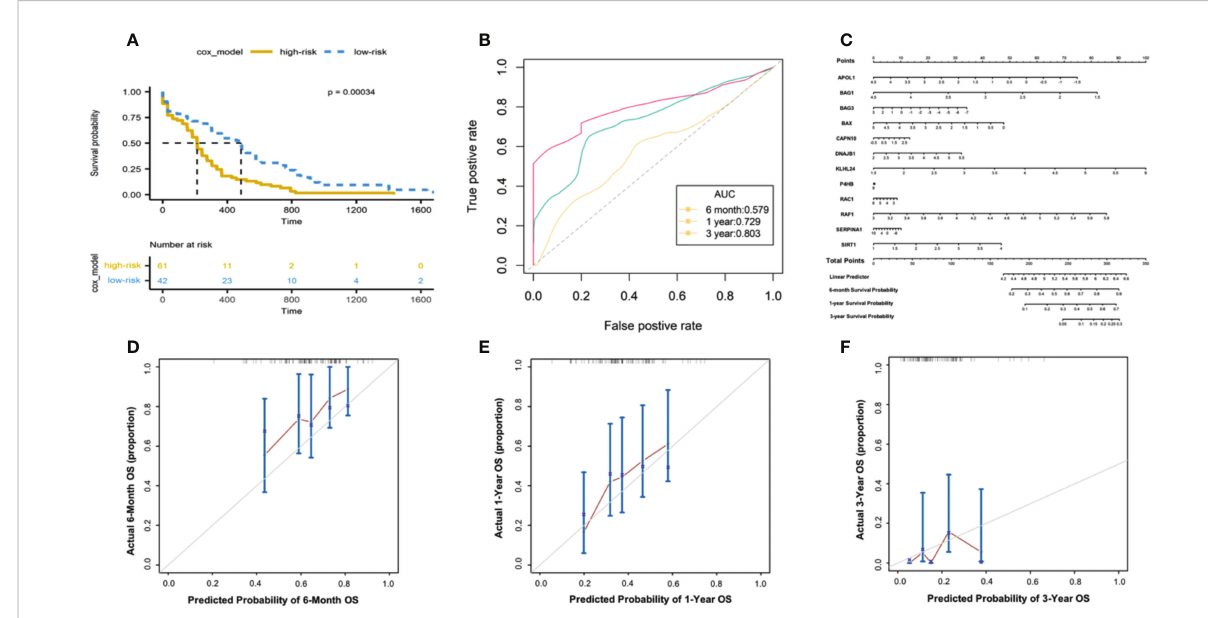
FIGURE 4 Evaluating the predictive power of risk scores in TCGA-AML cohorts. (A) Kaplan-Meier analysis based on the 12-gene signature in TCGA- AML cohort. Color denotes patients ’ strati fi cations based on risk scores. The table below shows the alive patients at individual time points. (B) The ROC curve showing the AUC of the predictions for 6-month, 1-year and 3-year survivals. (C) Nomogram constructed between the 12 autophagy-associated genes and 6-month, 1-year and 3-year survivals. The calibration plot of the nomogram showing the observed survivals and Nomogram-predicted survivals for 6-month (D) , 1-year (E) and 3-year (F) survivals.